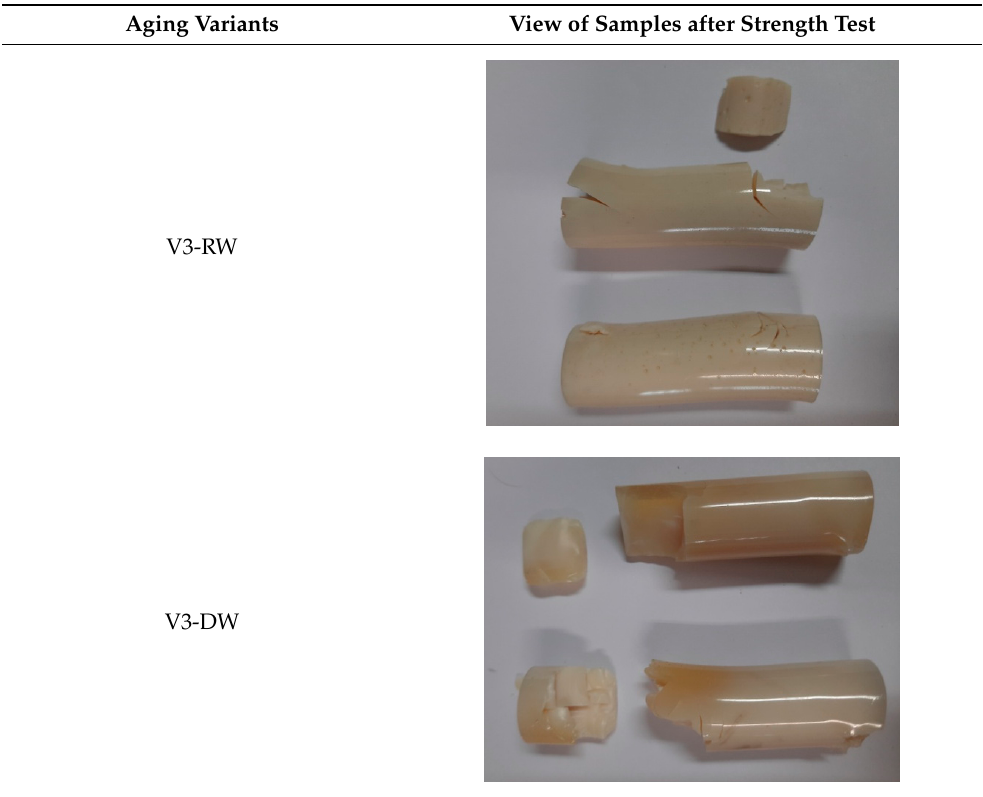
Table 7. View of the shape of the Epidian 57/Z-1/10:1 epoxy compounds sample—variant III.